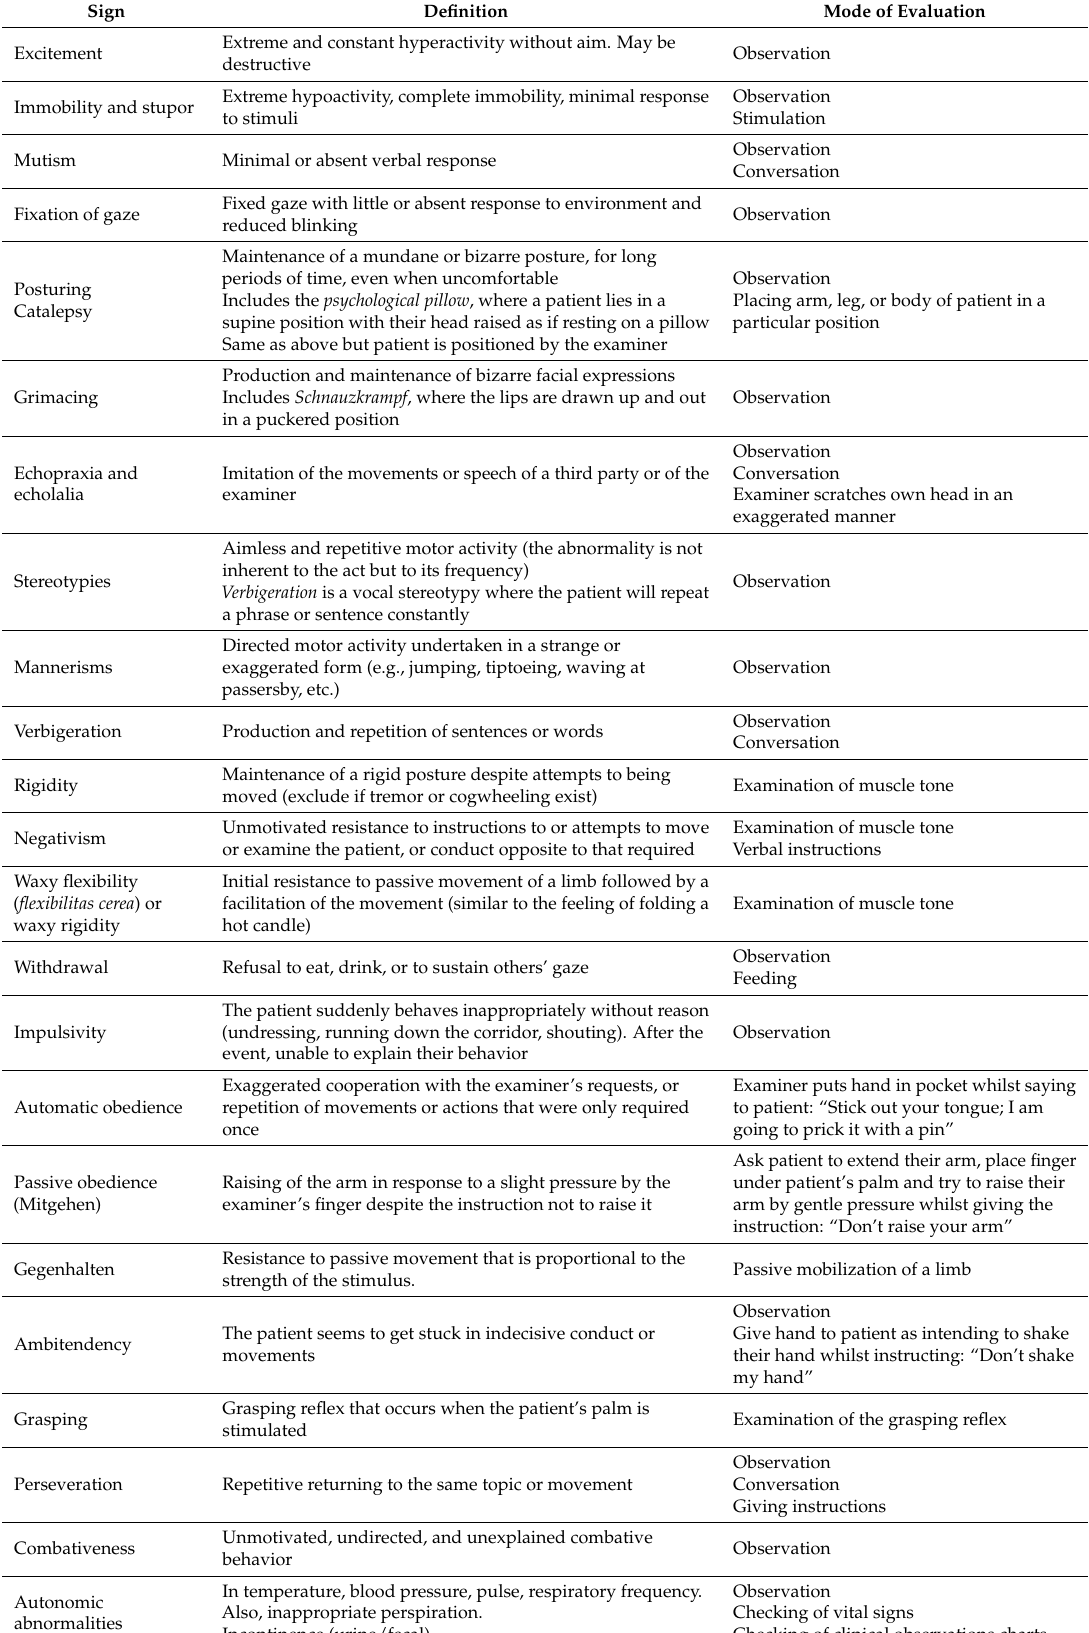
Table 2. Catatonic semiology and its